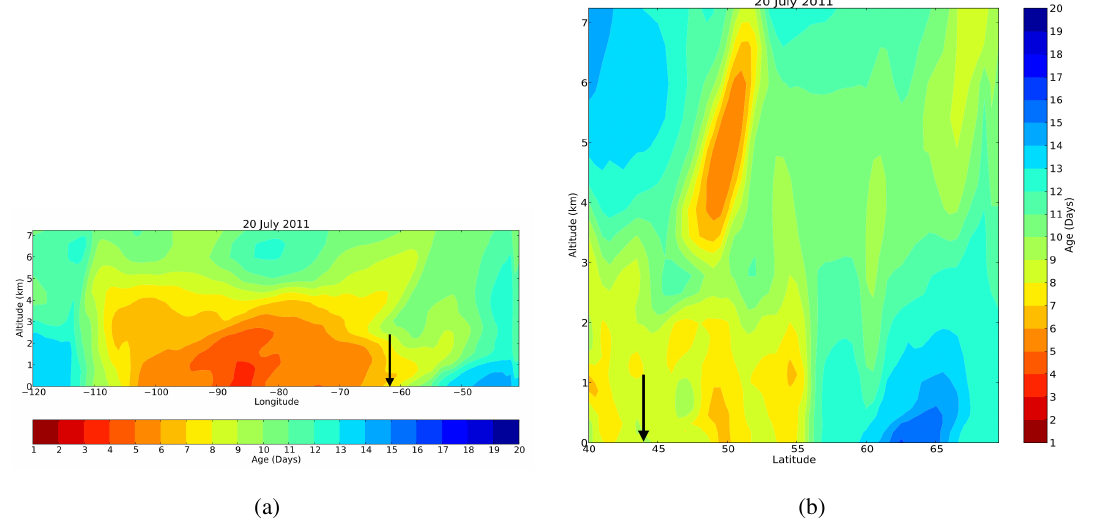
Figure 7. Age of emissions on 20 July 2011 (a) 120–40 ◦ W and 0–7km, averaged over 45–55 ◦ N; and (b) 40–70 ◦ N and 0–7km at 63 ◦ W, the same longitude as the Dalhousie University, Halifax, NS, surface measurements (Palmer et al., 2013). Location of Dalhousie University Fig. 7. Age of emissions on 20th July 2011 (a) from 120 ◦ –40 ◦ W and 0–7 km, averaged over 45 ◦ –55 ◦ N; is shown by the black arrow. and (b) 40 ◦ –70 ◦ N and 0–7 km at 63 ◦ W, the same longitude as the Dalhousie University, Halifax, NS surface measurements (Palmer et al., 2013). Location of Dalhousie University is shown by the black arrow.